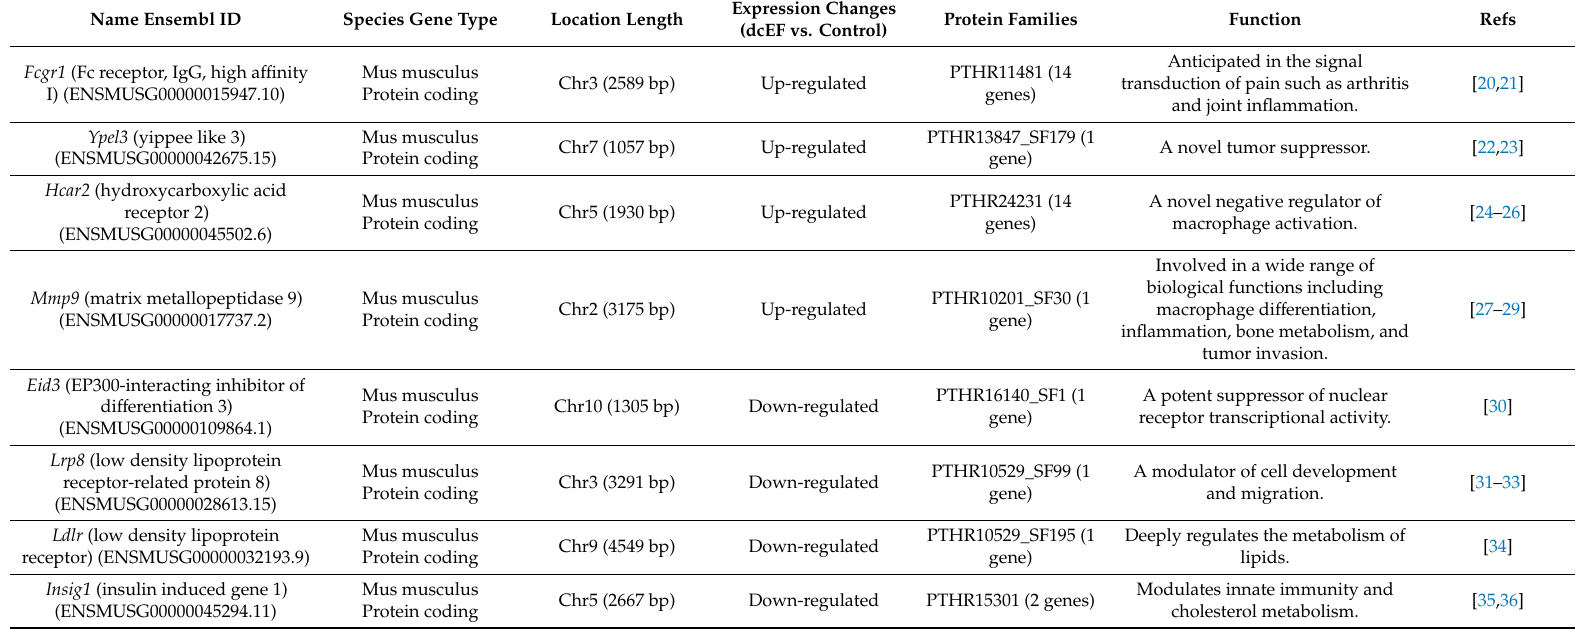
Table 5. dcEF-sensitive